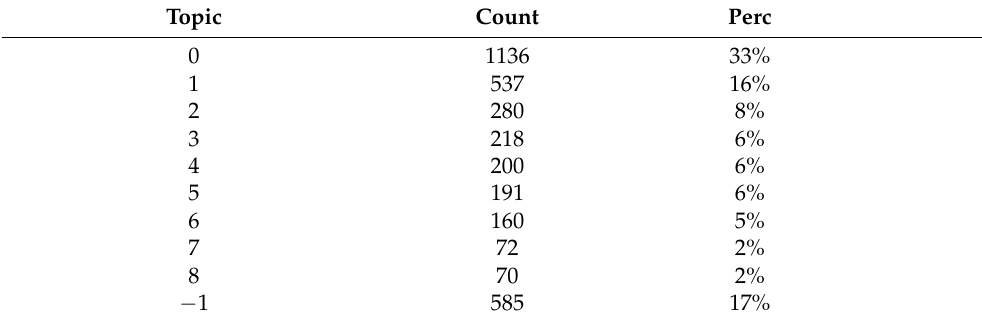
Table 3. Topics counts obtained with BERTopic and their relative proportions with respect to the whole